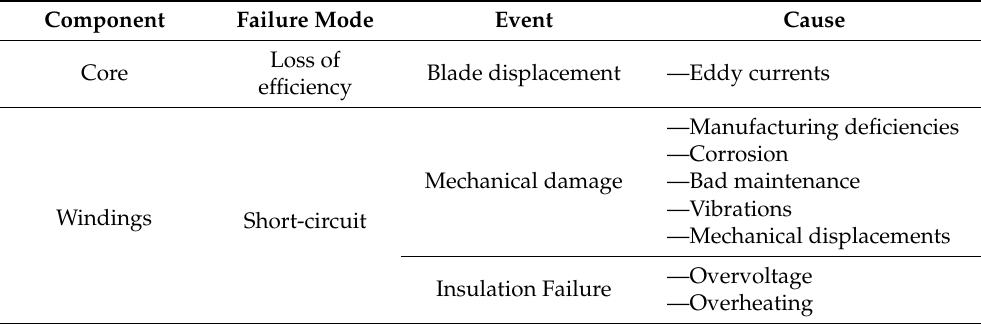
Table 1. Failure modes and common causes are associated with the most important transformers’ components.